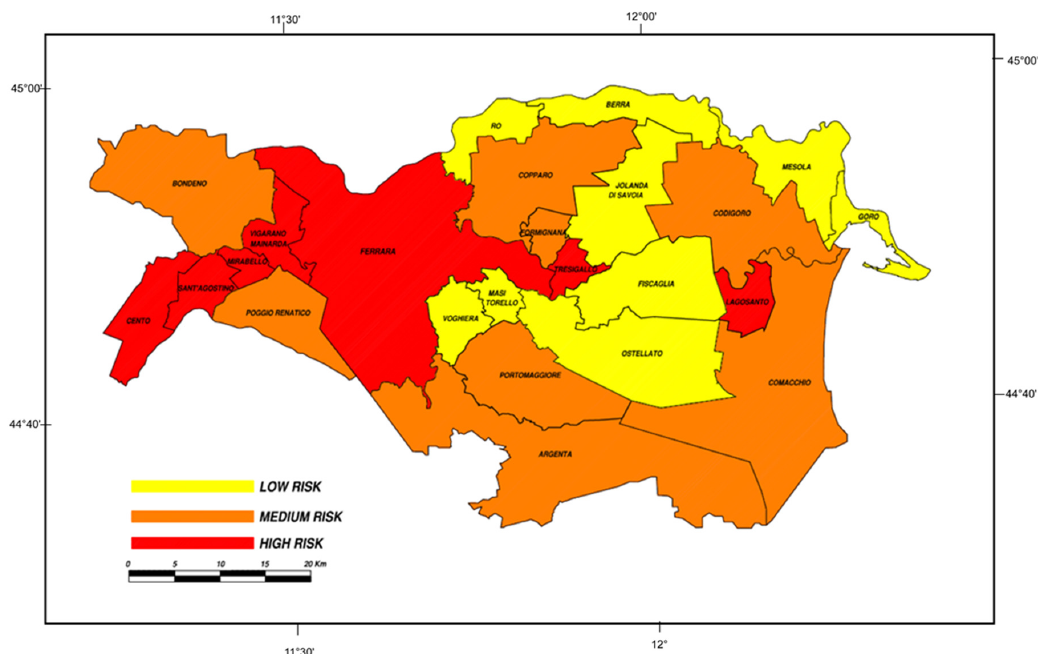
Figure 12. Multiple-risk map for the Ferrara province for the linear preference function with the thresholds chosen with the mean-std method. The risk levels strictly indicate the relative priority ranking for decision-makers and do not indicate the effective safety level of the various municipalities.